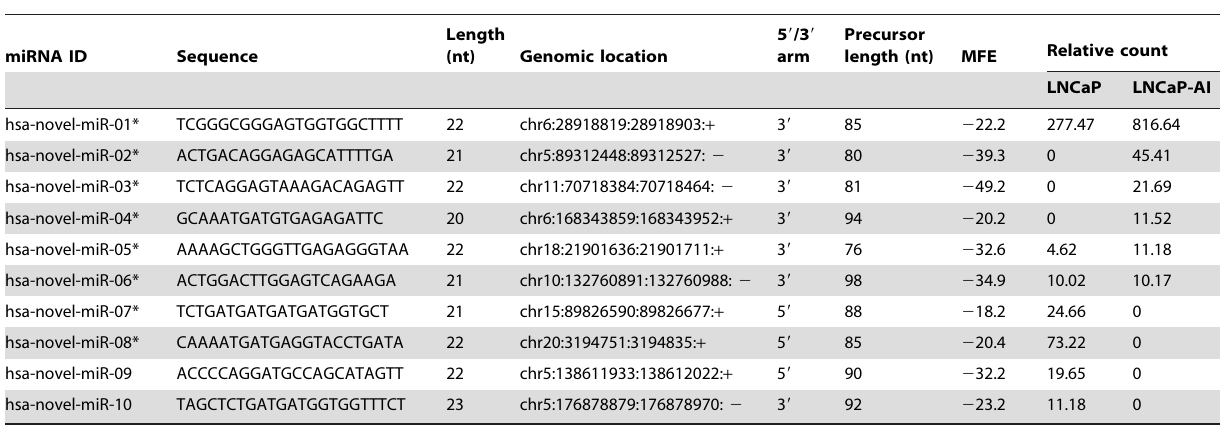
Table 2. The novel miRNAs validated by qRT-PCR.